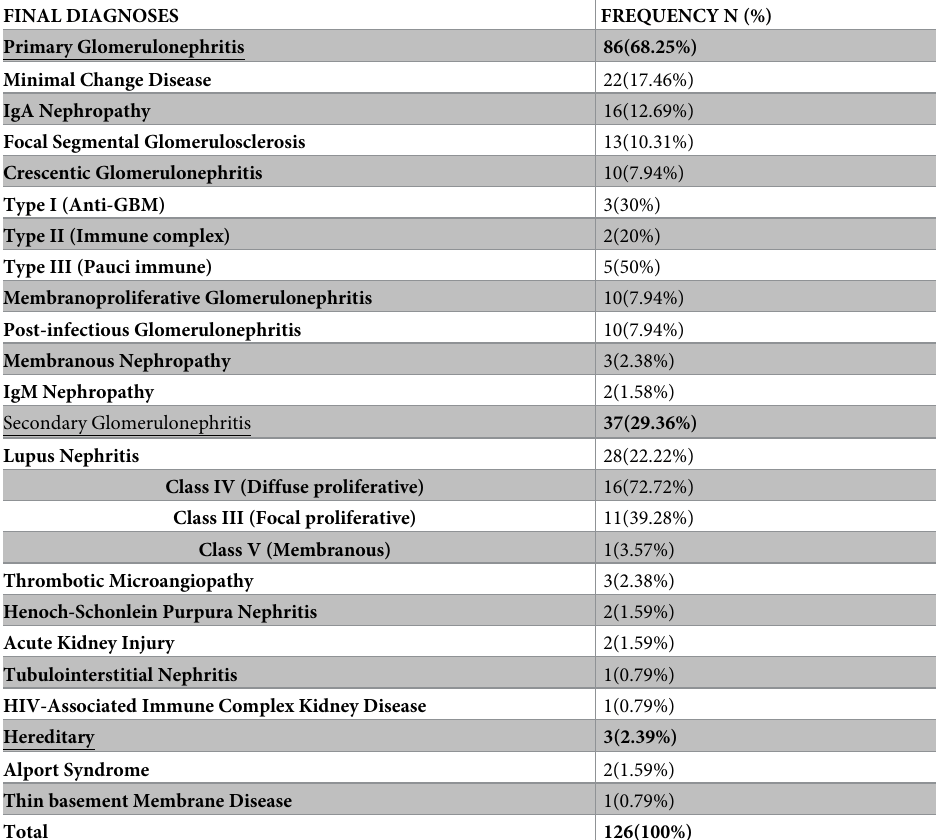
Table 1. Histopathological diagnosis (N = 126). FINAL